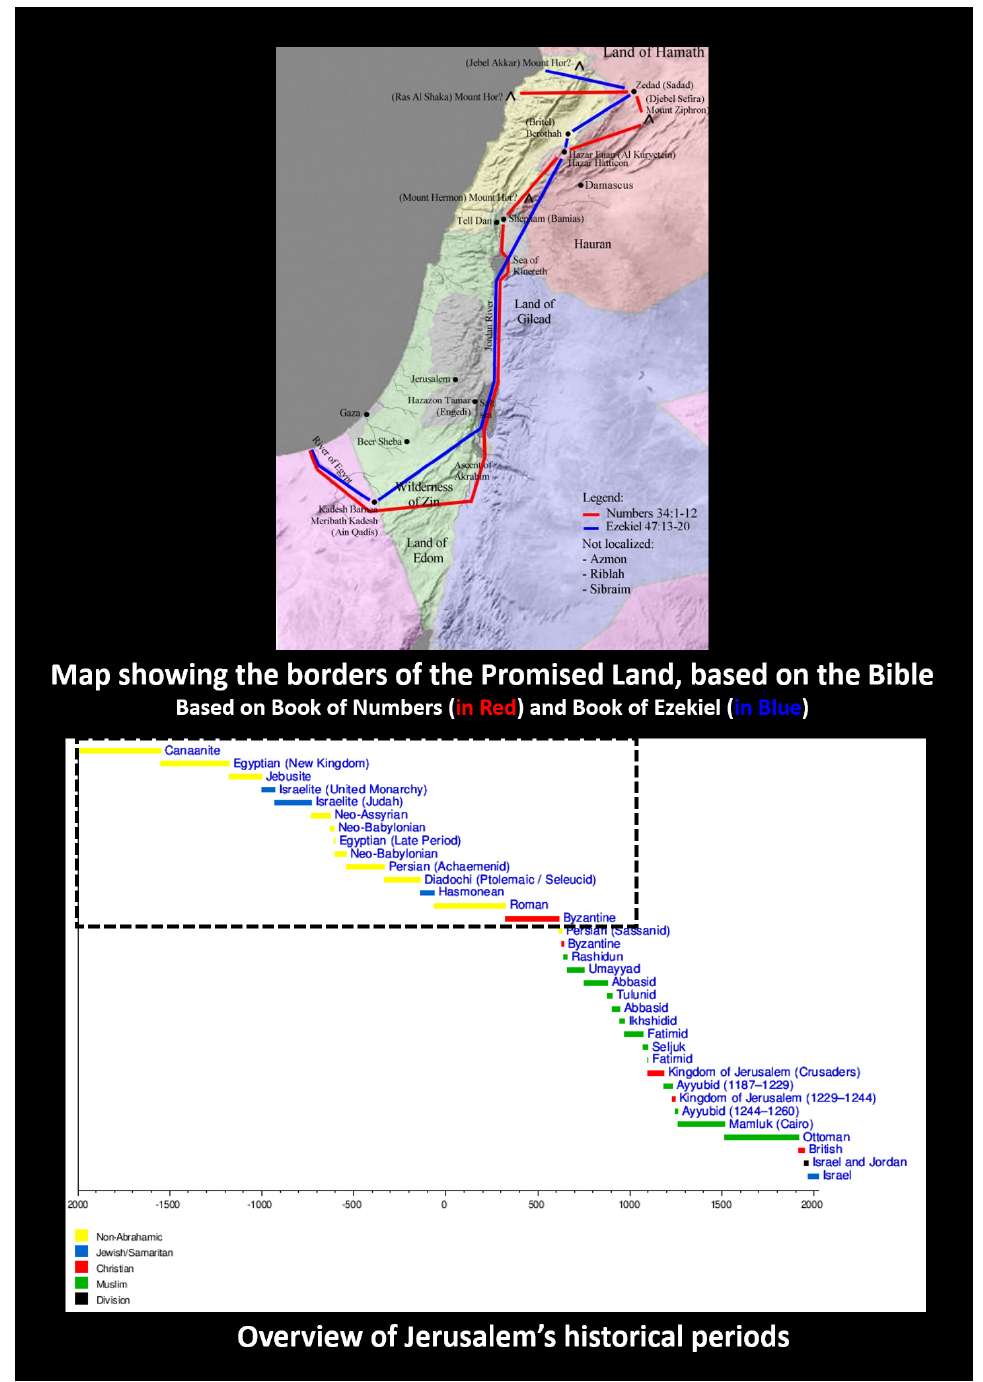
Figure 15. An illustrative map behind the concept of ‘Eretz Yisrael’ ( above ), the specific period of the artefacts in the museum highlighted on a complete timeline of the history of the contemporary state of Israel ( below